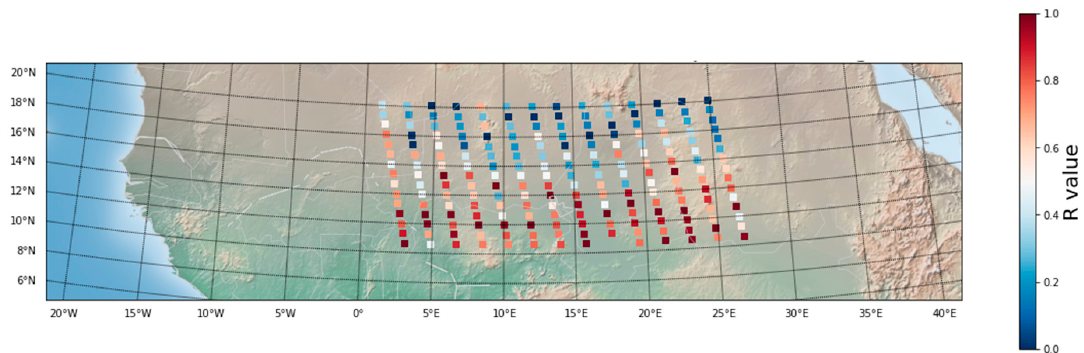
Figure 5. Correlation between VOD retrievals from Surface Waves Investigation and Monitoring (SWIM) backscattering coefficients acquired along the ascending tracks and NDVI from MODIS over the central part of the semi-arid region of Sahel in Africa.